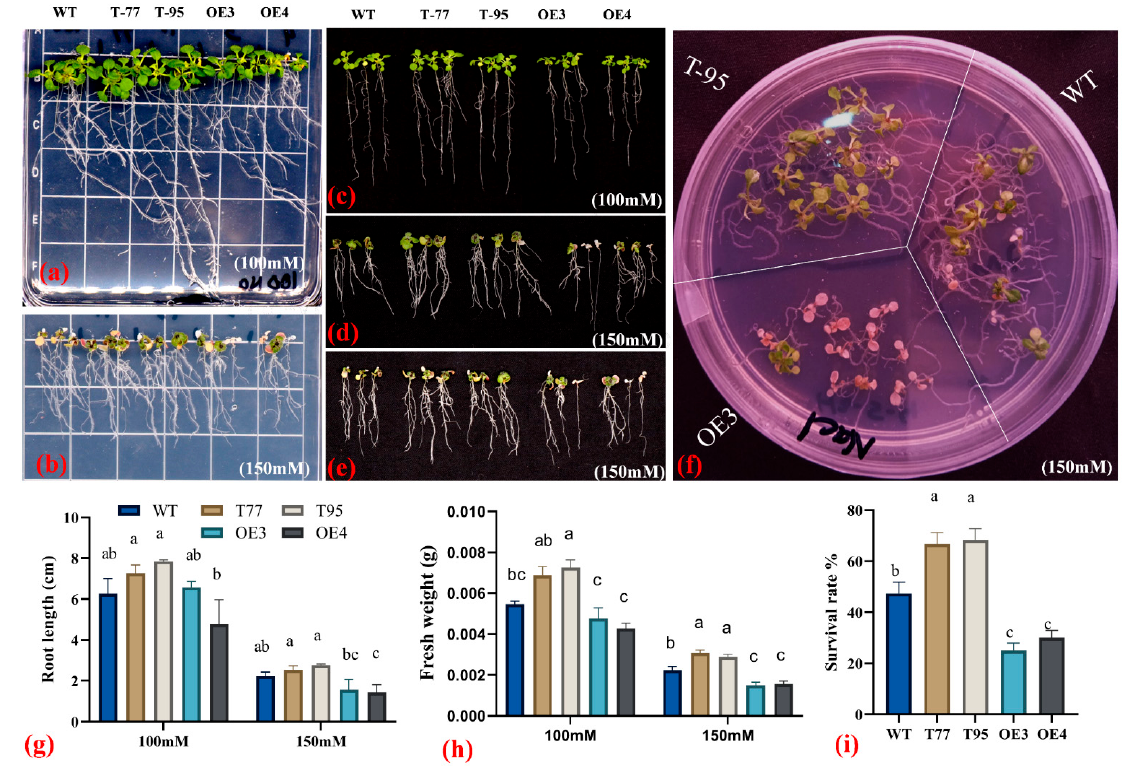
Figure 8. Comparison of salt stress tolerance of overexpressing TrHSFB2a lines and RNA interference T-DNA lines with wild type on 1/2MS medium supplemented with 100 or 150 mM NaCl. ( a , b ) show wild (WT), T-DNA lines (T-77 and T-95) and overexpression lines (OE3 and OE4) TrHSFB2a lines grown on 1/2MS medium supplemented with 100 mM and 150 mM NaCl, respectively, ( c – e ) show roots growth on 1/2MS medium supplemented with 100 mM and 150 mM NaCl, respectively; ( f ) plants survival/yellowing-related phenotypes on 1/2MS medium supplemented with 150 mM NaCl. ( g – i ) Show root length (cm), fresh weight (g) and survival rate (%) measured after 10 days of transplanting. Bars represent mean ± SD values determined from 30 seedlings, different small letters (a, b and c) represent significant statistical difference among means (one-way ANOVA, followed by Tukey test) between different lines within a treatment. Survival rate (%) was determined by counting survived and dead plants at 15 d of transplanting.